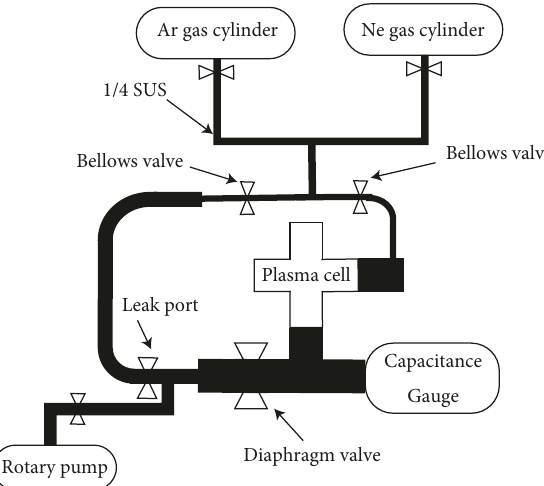
Figure 1: Diagram of the plasma experimental setup.